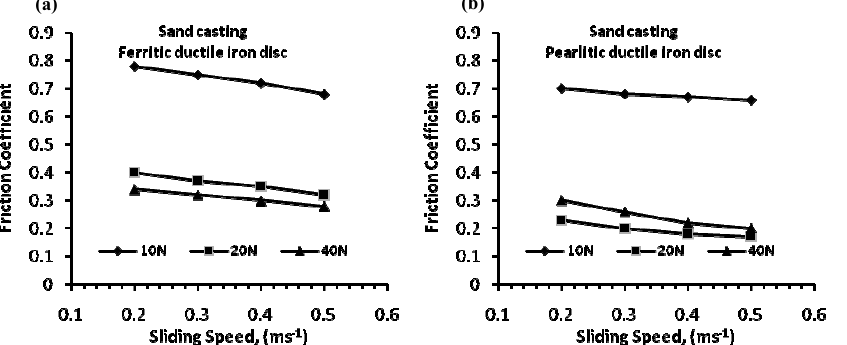
Figure 6. Variation of friction coefficient as a function of sliding speed at different loads and constant sliding distance (600 m) for centrifugally casting (a) ferritic ductile iron disc; (b) pearlitic ductile iron disc.